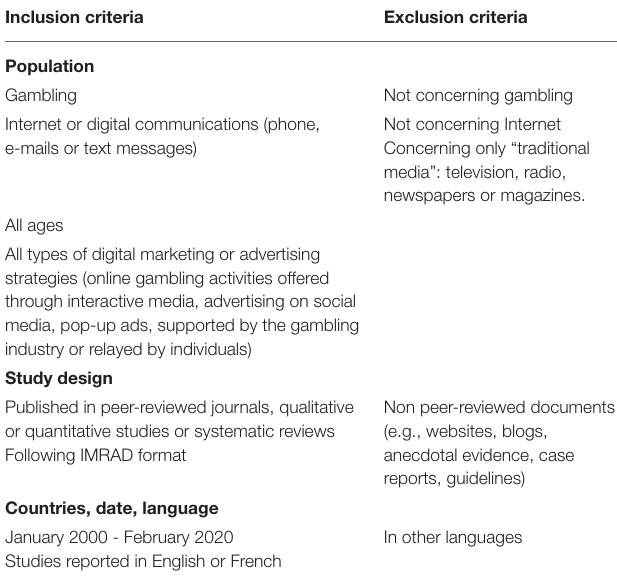
TABLE 1 | Inclusion and exclusion criteria. Inclusion